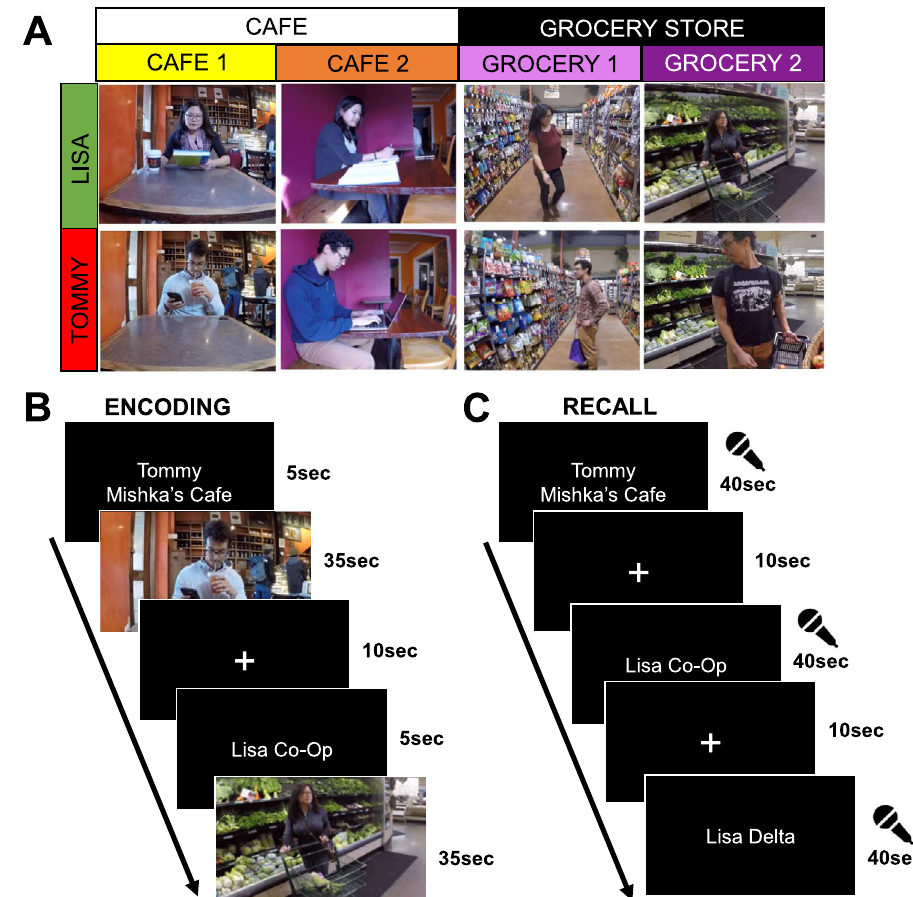
Fig. 1 | Experimental design and trial structure. A Eight videos were designed to systematically combine the information in events about local entities (i.e., central person) and contexts (i.e., speci fi c location), with an additional layer of context type(i.e.,cafévs.grocerystore). B Encodingtrialstructure(threeruns,randomized